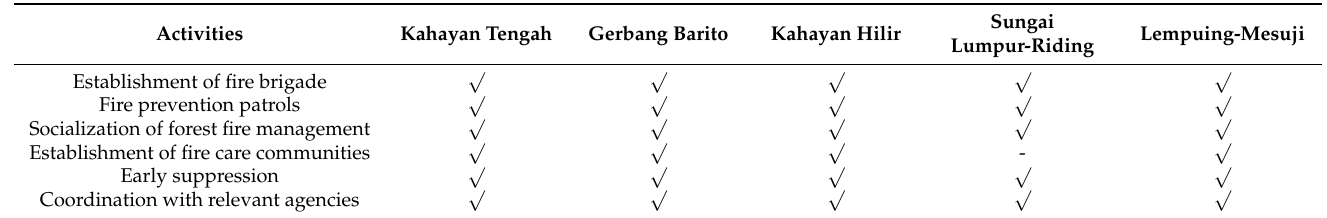
Table 3. Forest fire control programs implemented by FMU. Establishment of each given activity by √ each of the FMUs is signified by a ‘